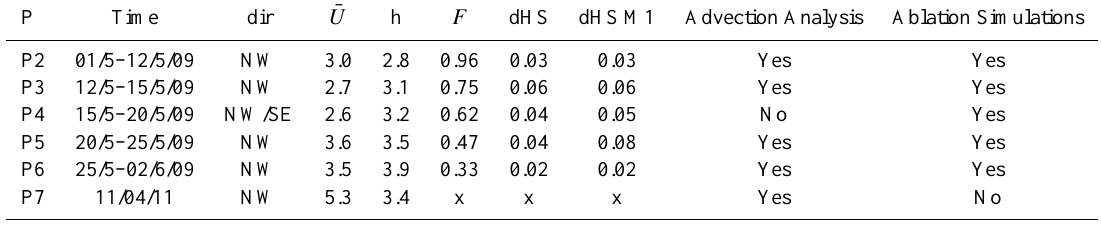
Table 1. Measured ablation periods (P) for the ablation season 2009 and ablation season 2011 used for the current analysis with start and end date (time), prevailing wind direction (dir) [ ◦ ] measured at wind station (WAN3), mean wind velocity ( ¯ U ) [m/s] and height (h) [m] of wind velocity measurements for respective period, modeled snow-coverage at the start of the period (F), measured mean daily change in snow